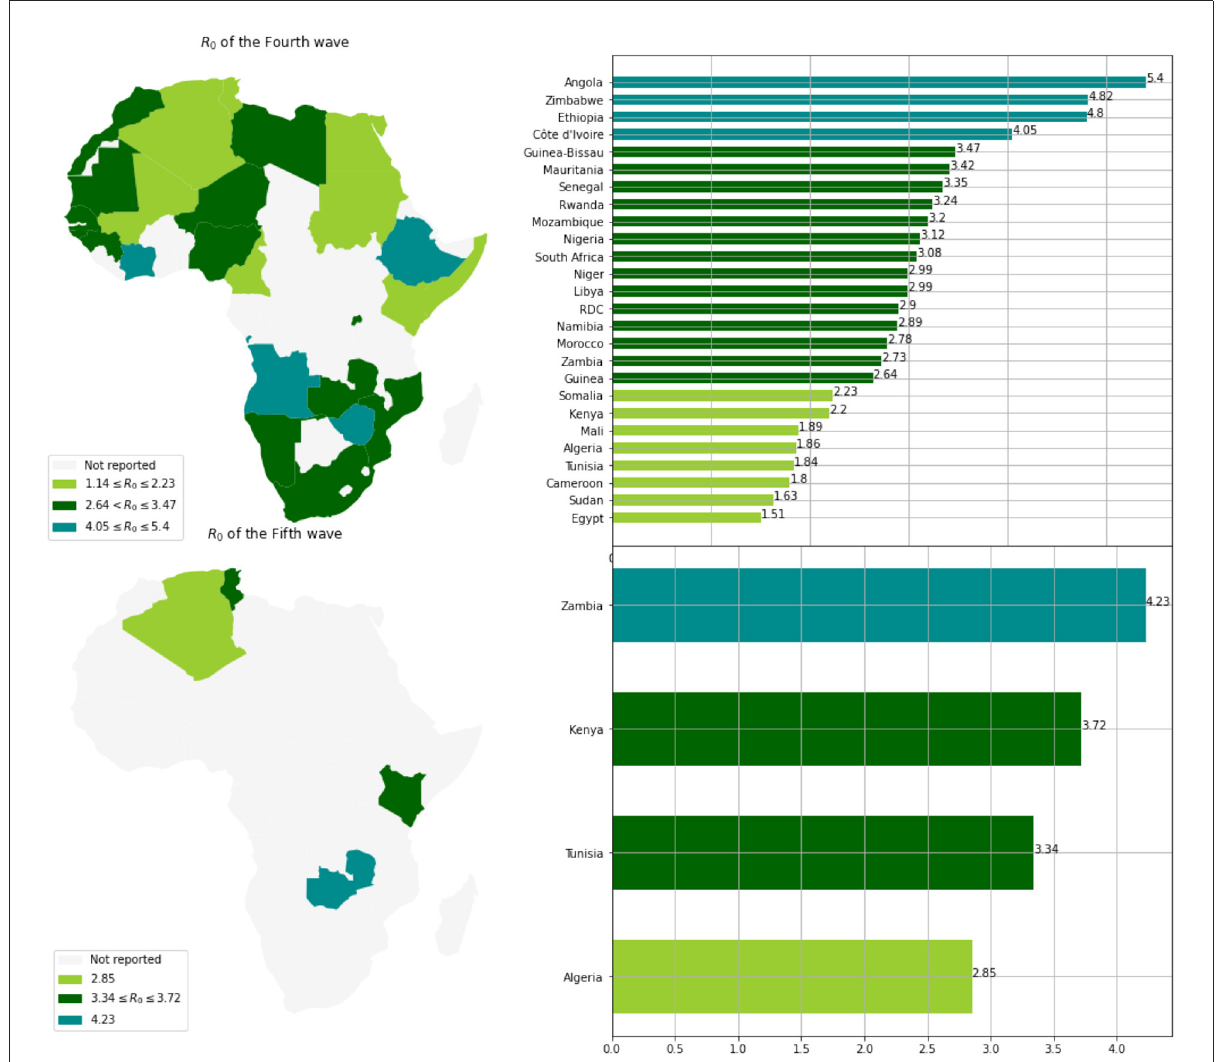
FIGURE5 Distribution of the R 0 of 30 countries in Africa for each